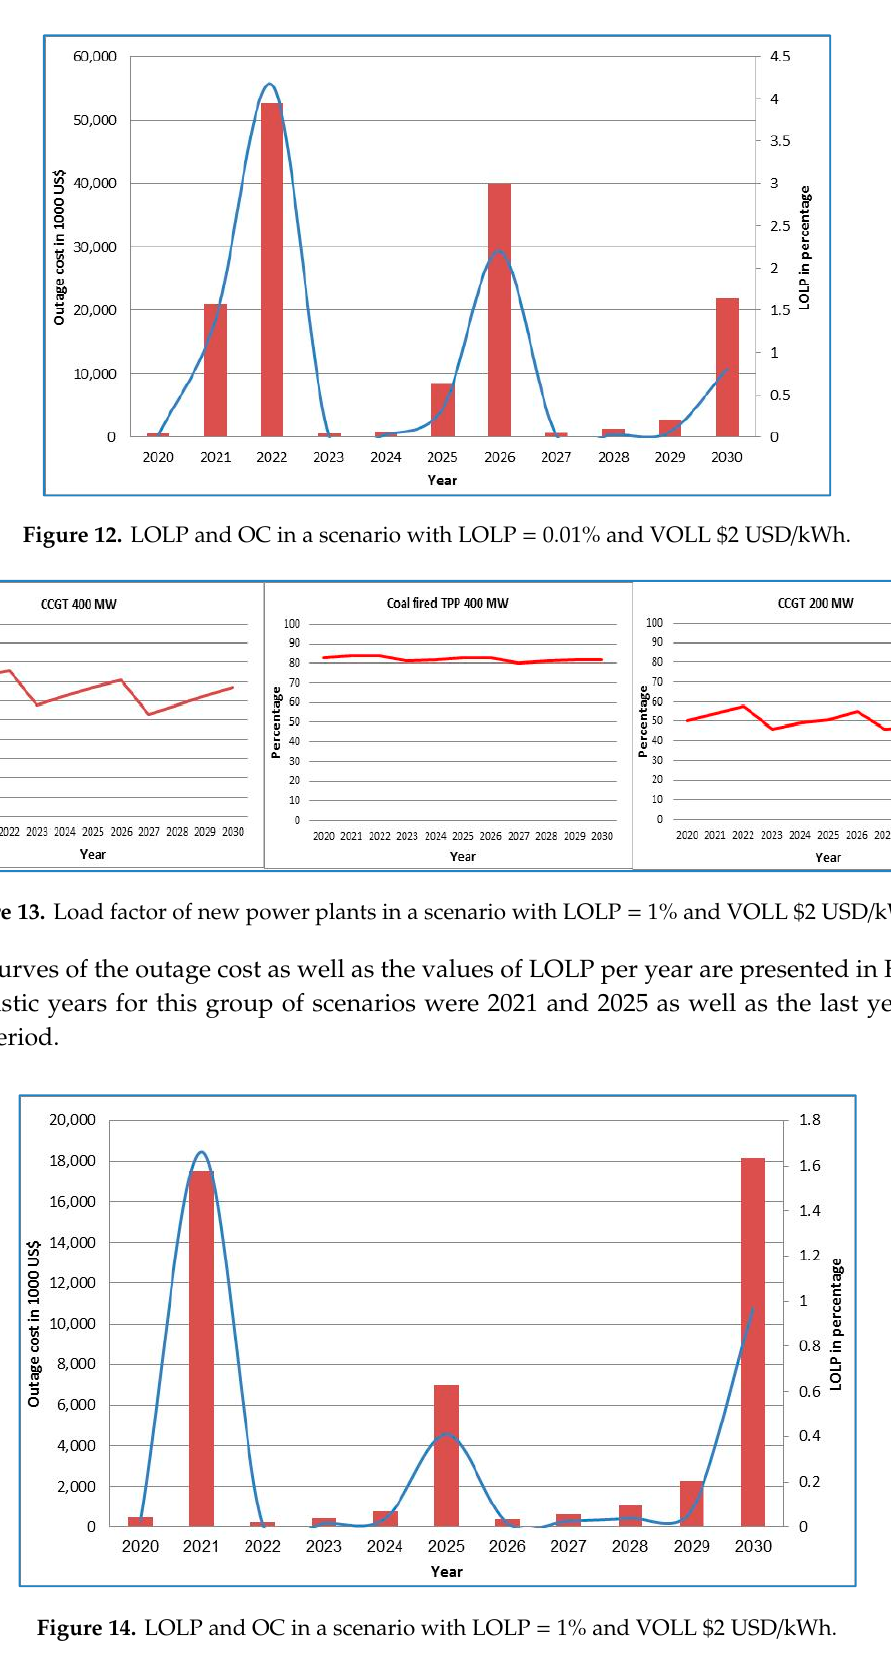
Figure 11. Load factor of new power plants in the LCP scenario and VOLL $2 USD/kWh.